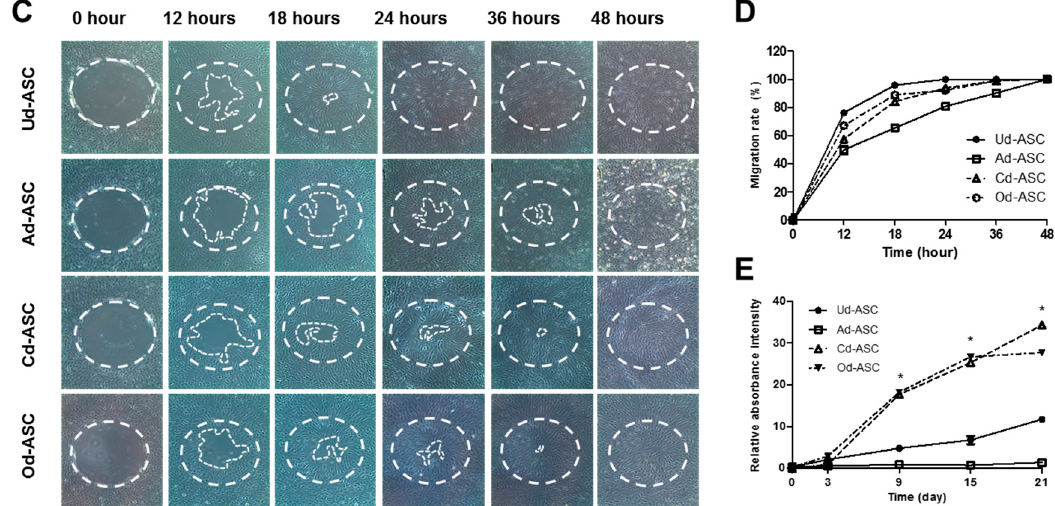
Figure 1. Characterization of hASCs. ( A ) hASCs were incubated with adipogenic, chondrogenic, and osteogenic differentiation medium for 21 days. The efficiencies of differentiation were determined by histological staining as Oil Red O staining, Alcian Blue staining, and von Kossa staining, respectively (scale bar = 50 μ m); ( B ) the mRNA expression of differentiation marker was measured by qPCR after 21 days of induction. The data are shown as the mean ± SEM ( n = 3, **: p < 0. 005, ***: p < 0.0005); ( C ) the migration of Ud-ASC, Ad-ASC, Cd-ASC, and Od-ASC were investigated using Radius™ 24-Well Cell Migration Assay. The broken line circles indicate the rim of the cells prior to migration; ( D ) the quantitative data of the migration area was calculated by ImageJ software ( n = 3); and ( E ) the proliferation of Ud-ASC, Ad-ASC, Cd-ASC, and Od-ASC was measured using CCK-8 kit. The data are shown as the mean ± SEM ( n = 3, Ud-ASC vs. Cd-ASC, *: p < 0. 05).